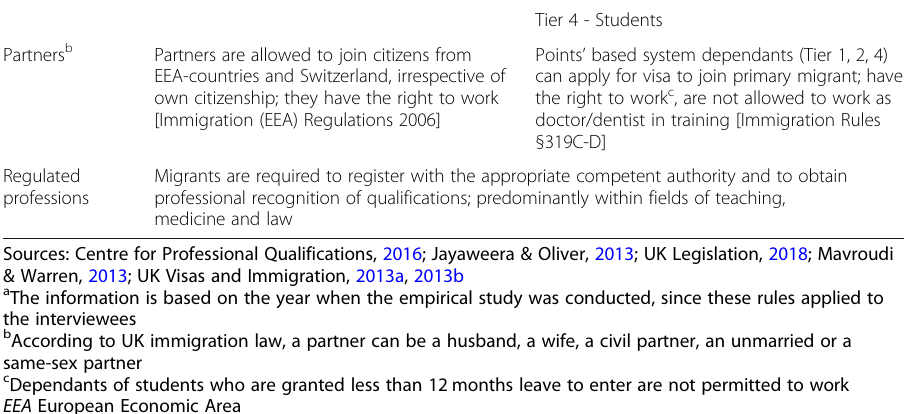
Table 1 Rules for immigration and working in the UK (UK Visas and Immigration, 2013 a ) Citizens from European Economic Area [EEA] - countries and Switzerland as well as partners of these citizens Primary migrants Right of residence and right to work in the UK Undergo points ’ assessment Partners b Partners are allowed to join citizens from EEA-countries and Switzerland, irrespective of own citizenship; they have the right to work [Immigration (EEA) Regulations 2006]